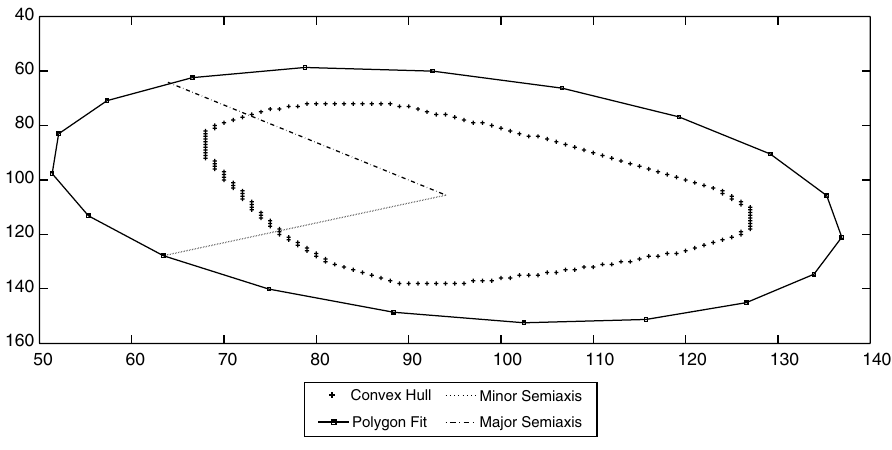
Fig. 8. Illustration of the Major (dashed line) and Minor (dotted line) semiaxes located on a contour obtained from human upper-arm movement. The polygon boundary used to calculate the two semiaxes is shown with square markers.